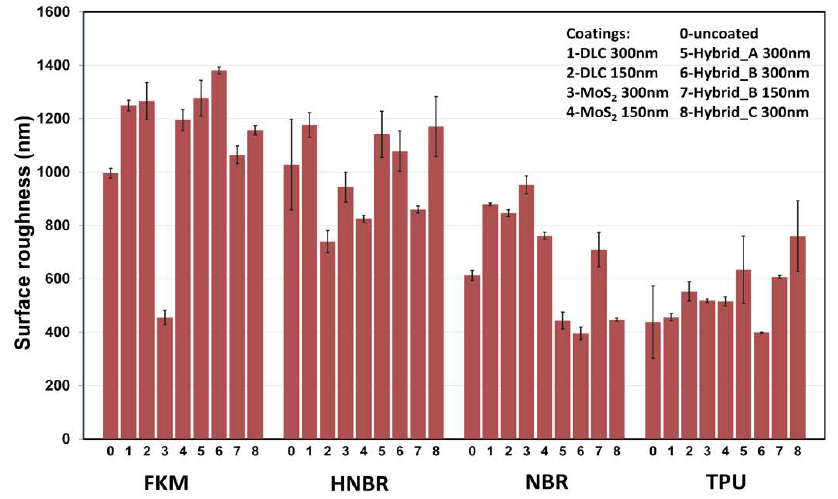
Figure 4. Surface roughness ( R a ) of uncoated and coated substrates.